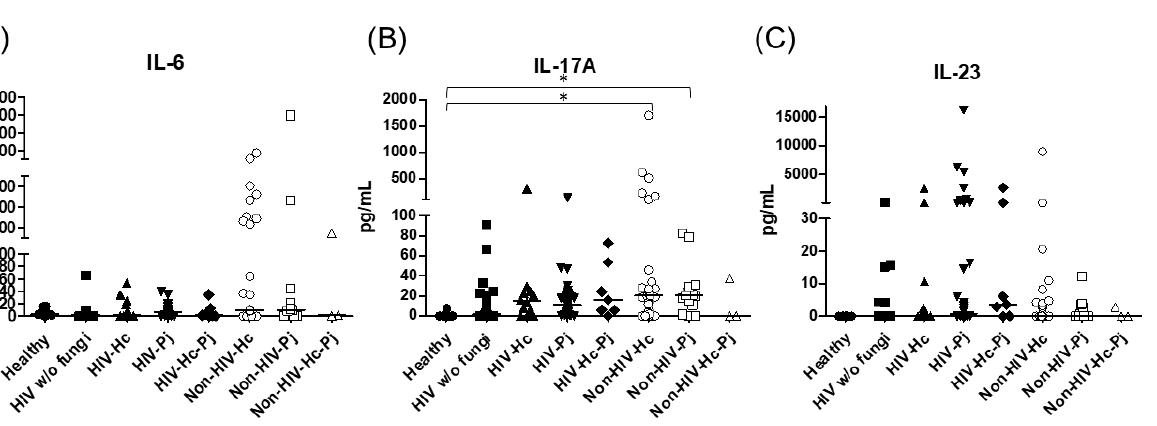
Figure 6. Determination of cytokines associated with granuloma formation. IL-33, IL-5, and IL-13 were detected by a cytometric bead assay in the BAL samples of hospitalized patients; results were obtained in pg/mL. Median values are shown for ( A ) IL-33, ( B ) IL-5, and ( C ) IL-13. * p < 0.05.